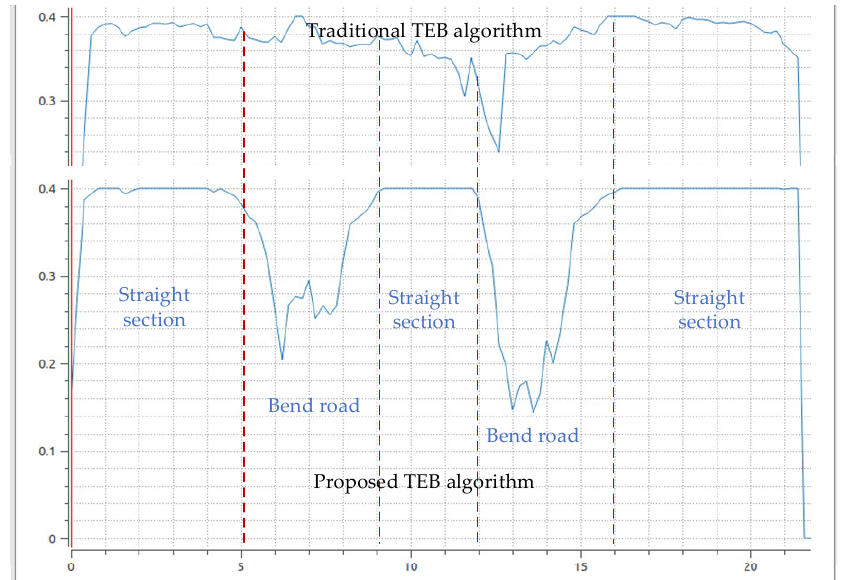
Figure 7. AGV speed output curve of the traditional TEB algorithm and the proposed TEB algo-